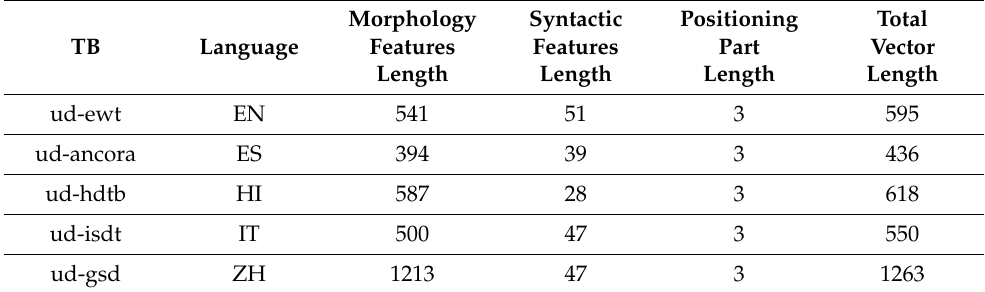
Table 2. The lengths of vector encoding for the five languages studied. Note that each treebank has a different number of morphological and syntactic